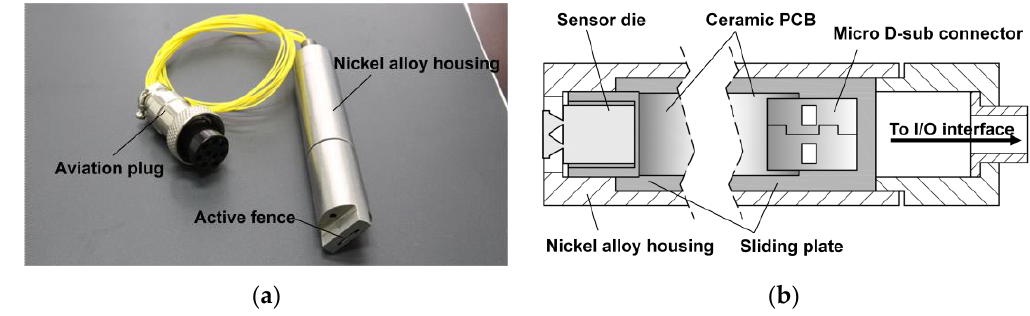
Figure 3. ( a ) Photograph of the packaged surface fence sensor; ( b ) A length-wise cross-section illustration of the shear-stress sensor package designed for use in high-temperature environment.